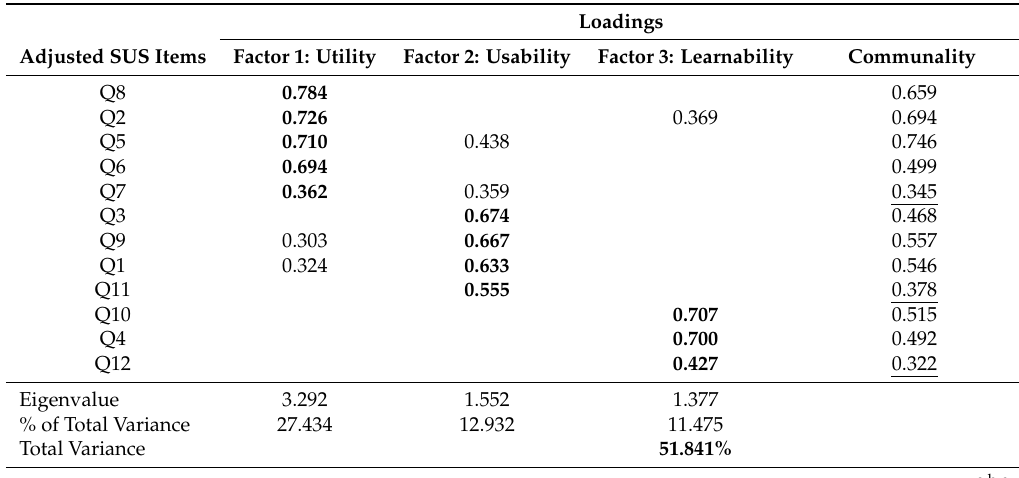
Table 2. Factor analysis table for the adjusted system usability scale